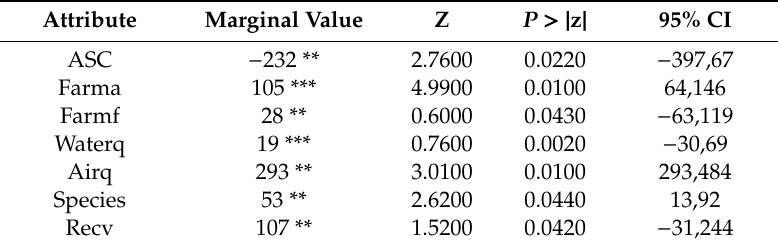
Table 5. Part-worths estimated at their mean